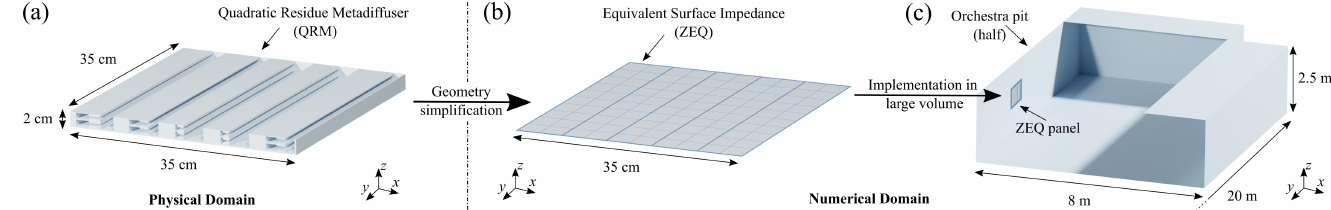
Figure 1. Conceptual diagram illustrating ( a ) a render of a Quadratic Residue Metadiffuser (QRM) with N = 5 slits, ( b ) a numerical equivalent surface impedance (ZEQ) of the metadiffuser identically composed of N = 5 slits, and ( c ) an implementation of the ZEQ into a large computational volume, e.g., an orchestra